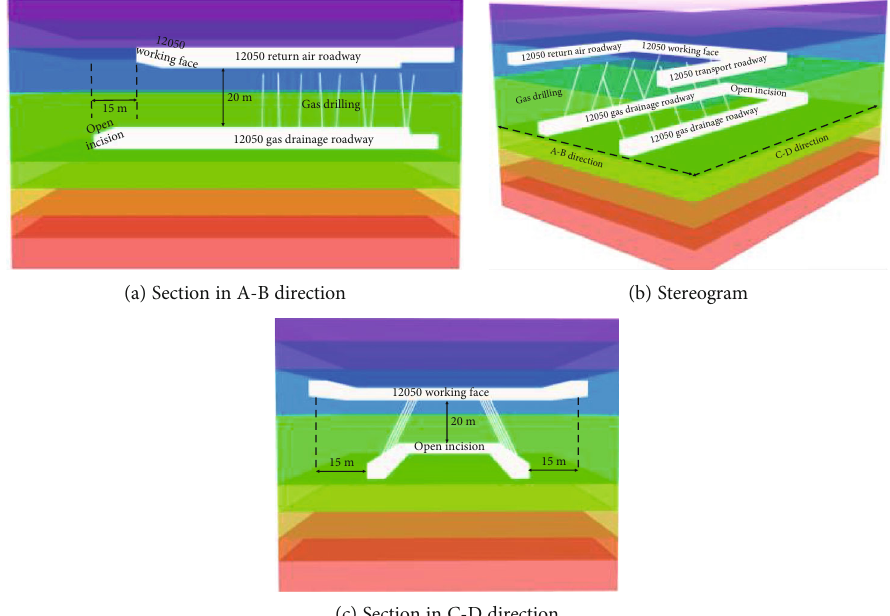
Figure 23: Layout of FGDR and its open-o ff